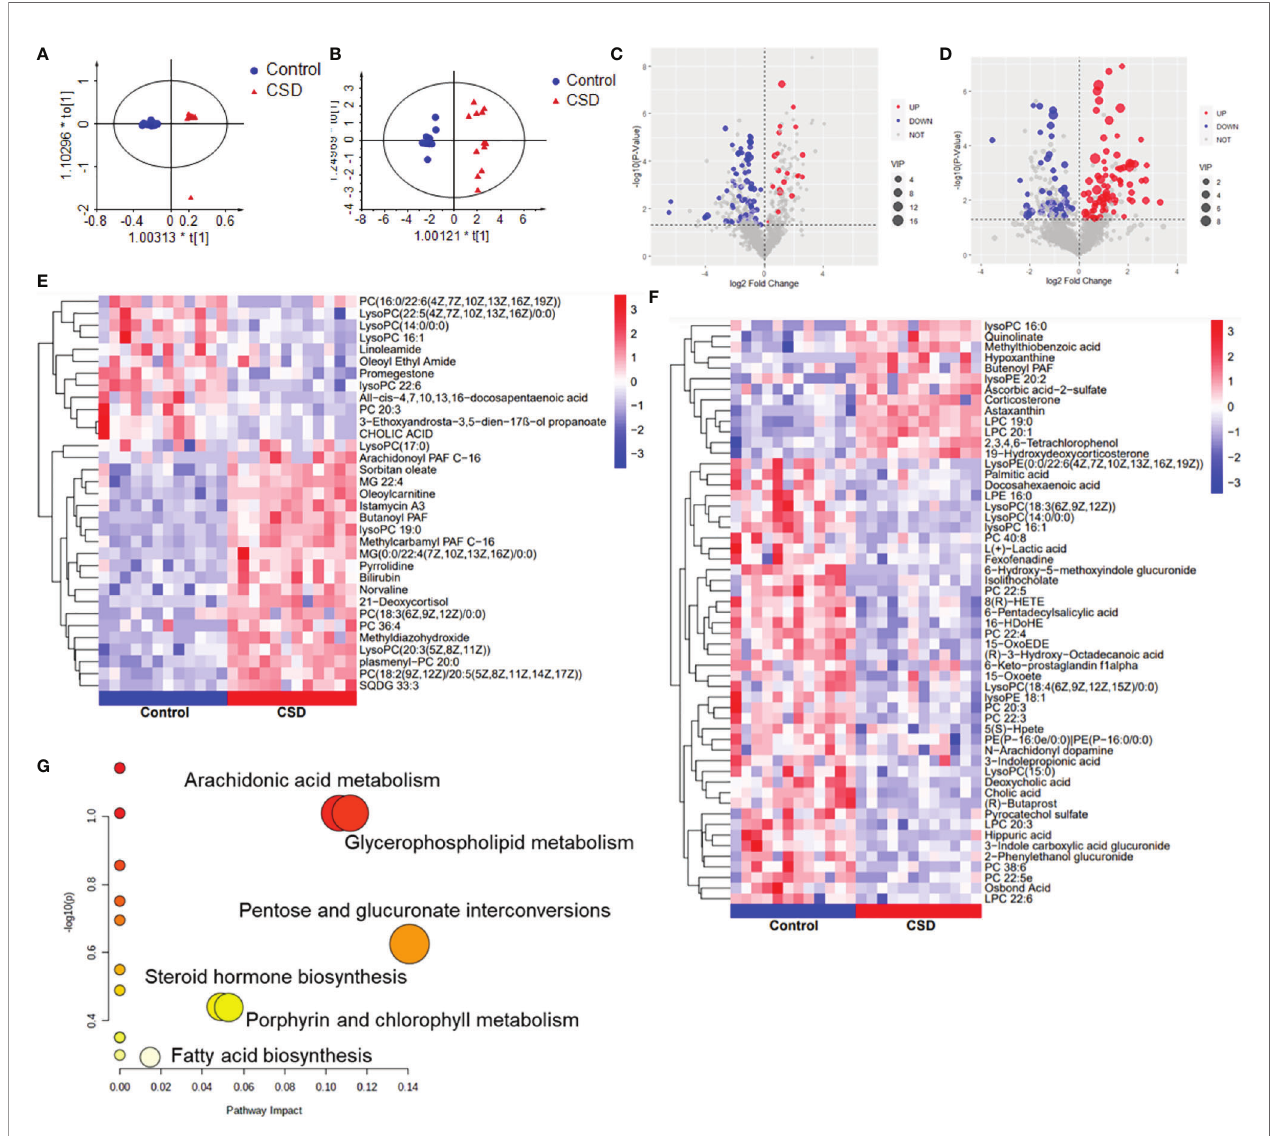
FIGURE 5 | The effects of CSD on serum metabolic pro fi ling in rats. Orthogonal partial least squares discriminant analysis (OPLS-DA) score plot for the control group vs the CSD group in (A) negative mode and in (B) positive mode. Volcano plots for the control group vs the CSD group in (C) positive mode and (D) negative mode. Heat map of the hierarchical clustering analysis of the differential metabolites for the control group vs the CSD group in (E) positive mode and (F) negative mode; the color represents the relative level of the differential metabolite with a gradient from red (high levels) to blue (low levels). (G) Metabolic pathway analysis results based on the differential